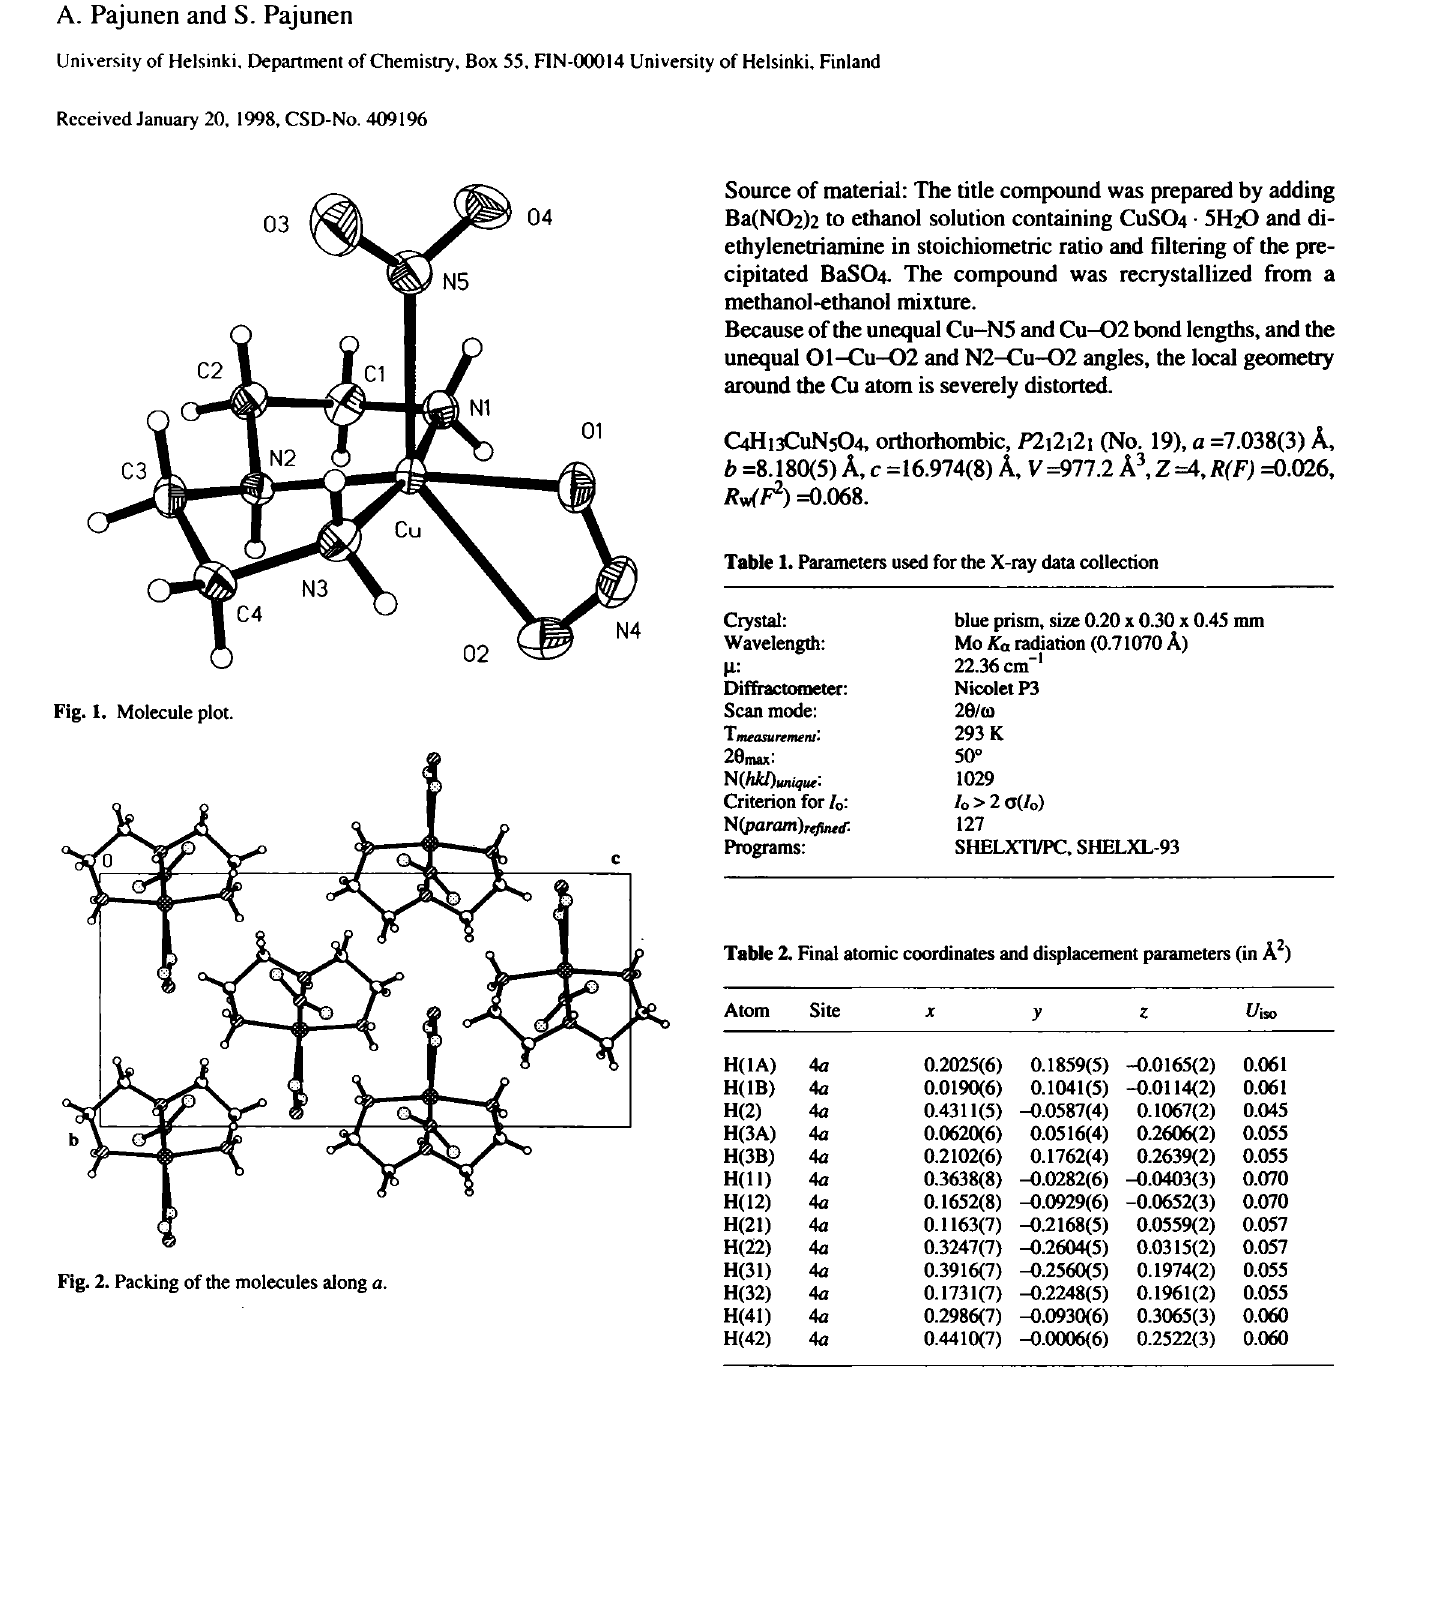
Fig. 2. Packing of the molecules along a.